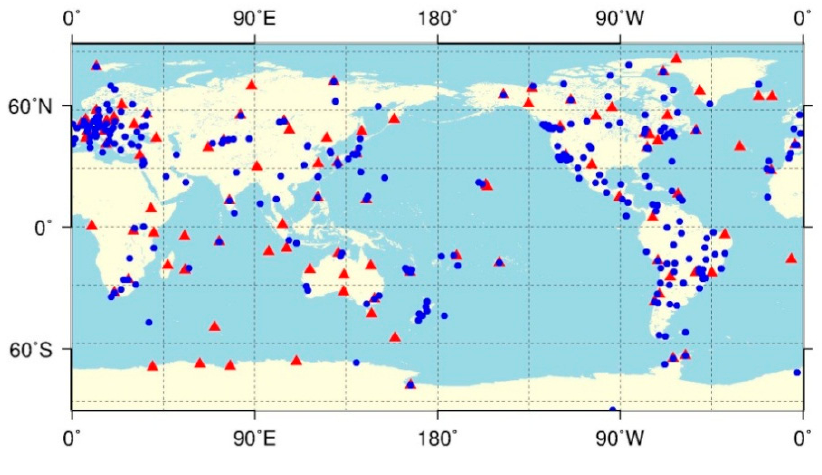
Figure 3. Station distribution of the experimental network. There are about 450 stations in total. Among them, about 100 stations indicated with red triangles, are used for orbit determination and high-rate clock estimation, while the blue dots indicate the other about 350 stations for assessing product